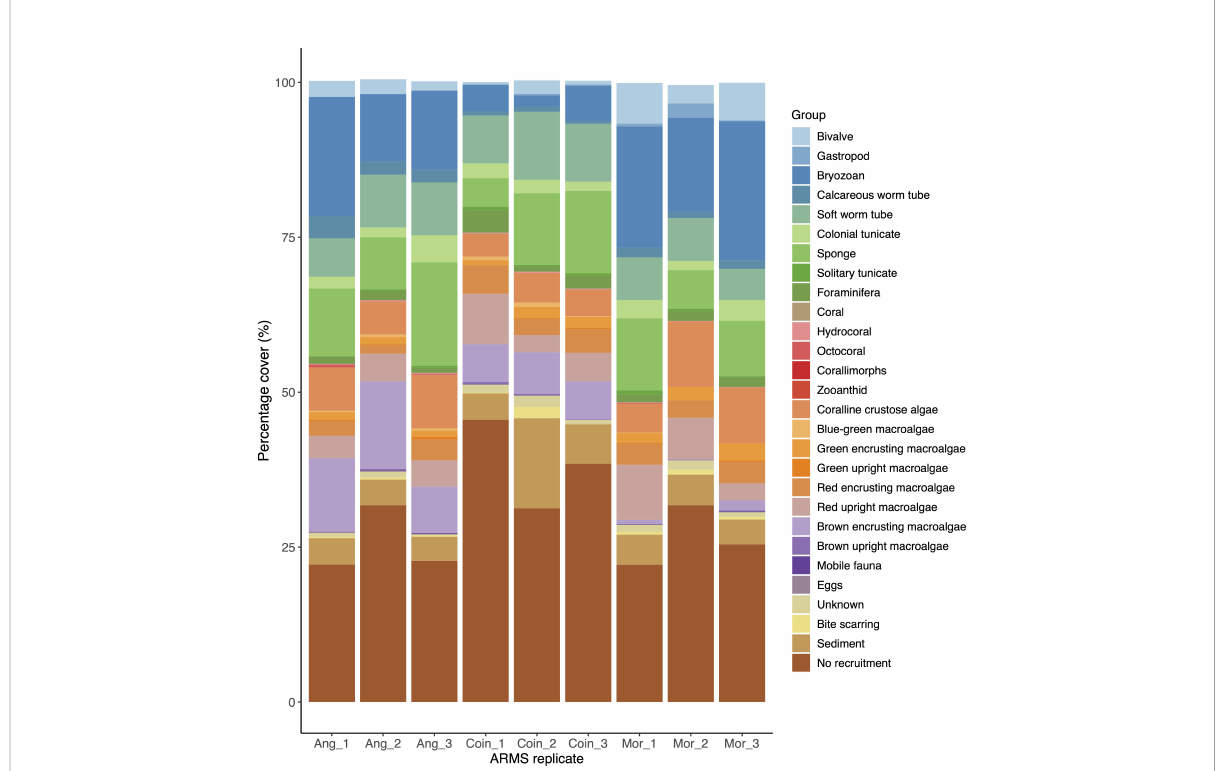
FIGURE 5 Stacked barplot displaying the percentage cover of sessile taxonomic groups, the percentage of counts assigned to non-sessile taxa as well as other identi fi cation groups, across replicates of autonomous reef monitoring structures (ARMS) from each sampling site (Ang, Ile Anglaise; Coin, Ile du Coin; Mor,